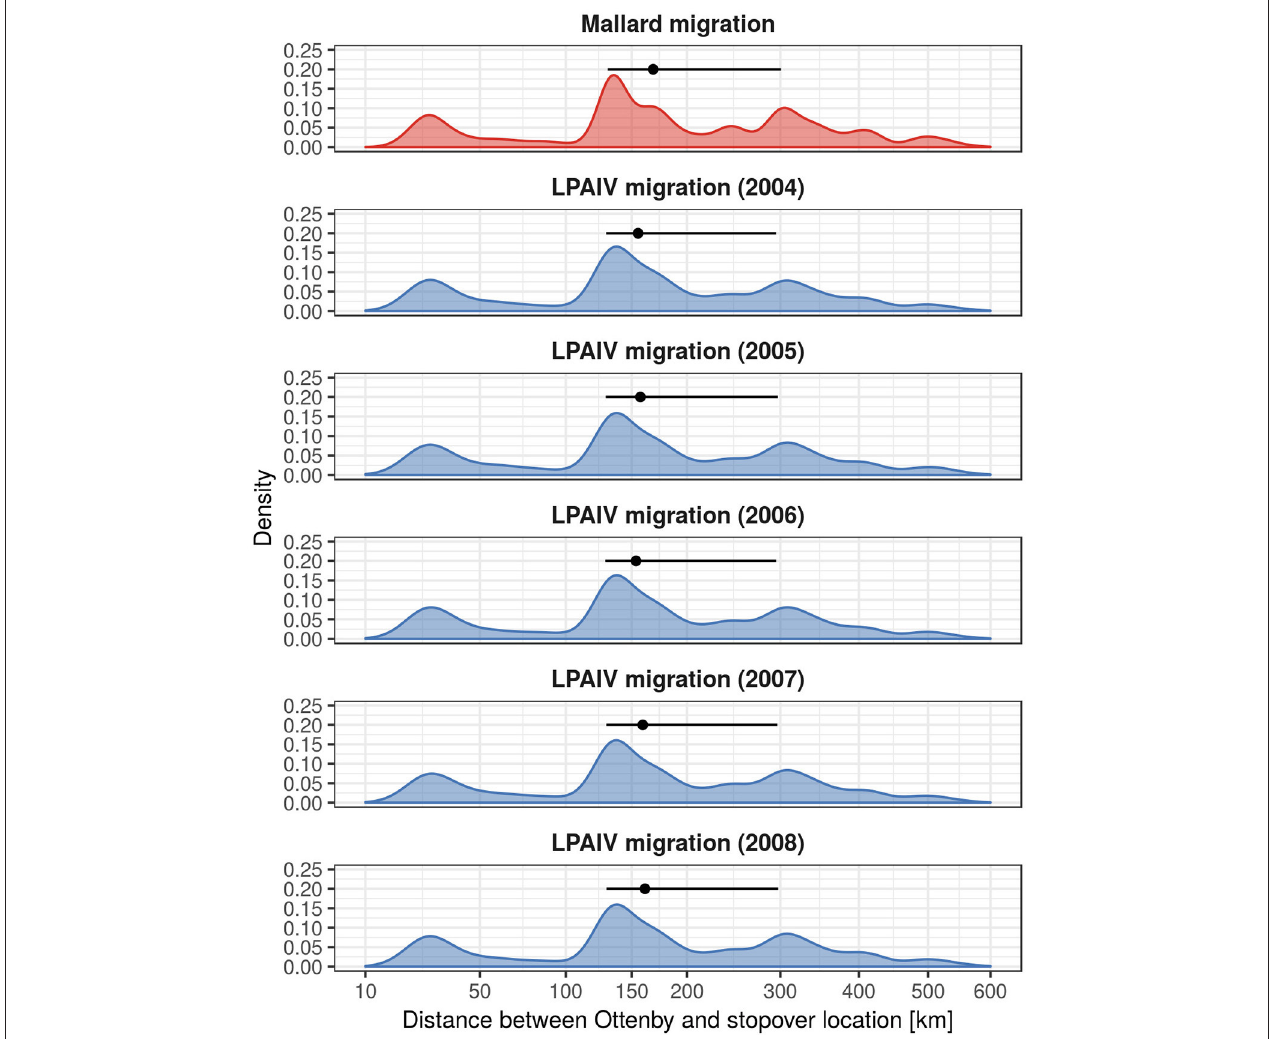
FIGURE 3 | Migration distances of mallards migrating from Ottenby, and the dispersal distances of LPAIV. The density curves show the distribution of migratory distances of 10,000 randomly sampled migratory trajectories on a squareroot scale. The point ranges display the median and the 25- and 75%-quantiles, respectively. Notice the presence of multiple peaks in the distributions, which are a result of the shape of the lower Baltic and its coastlines. Density curves were produced using ggplot2 (Wickham, 2016) with default settings.